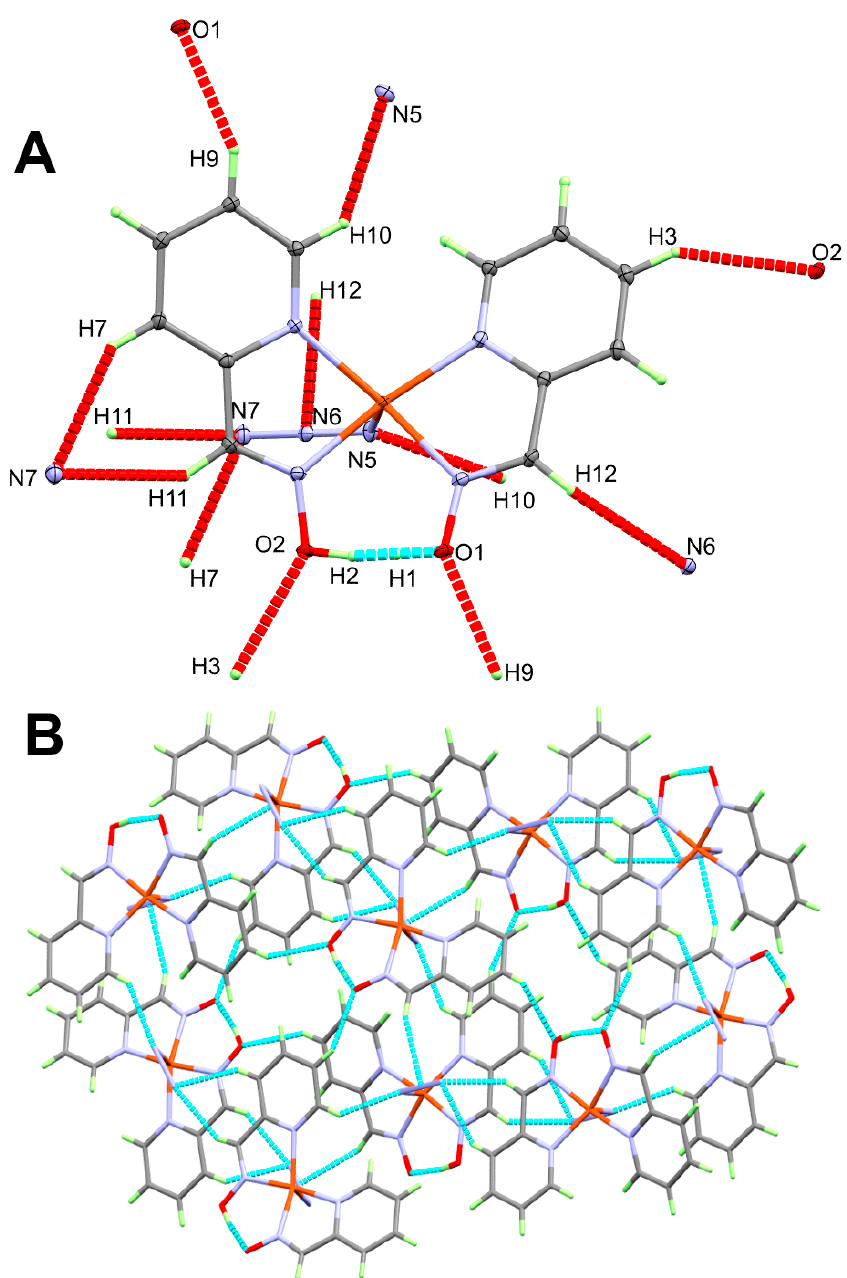
Figure 6. Hydrogen bridge contacts ( A ) and packing view along a-axis ( B ) in 2 .